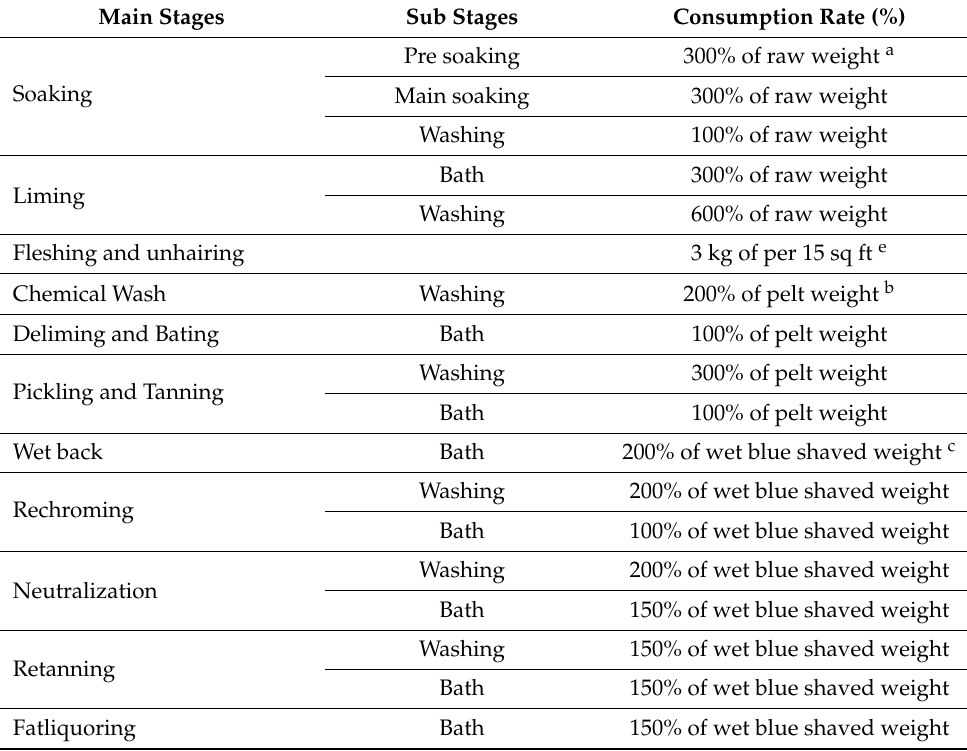
Table 1. Water consumption rate (%) for leather production in tanneries in